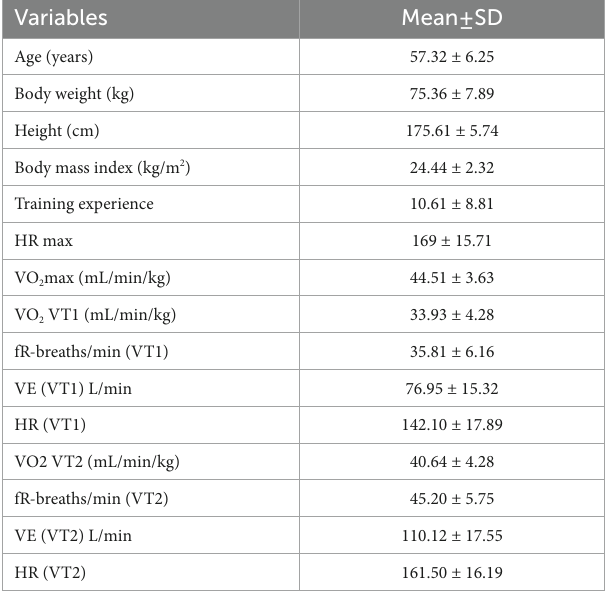
TABLE 1 Baseline characteristics of the participants, presented as mean ±